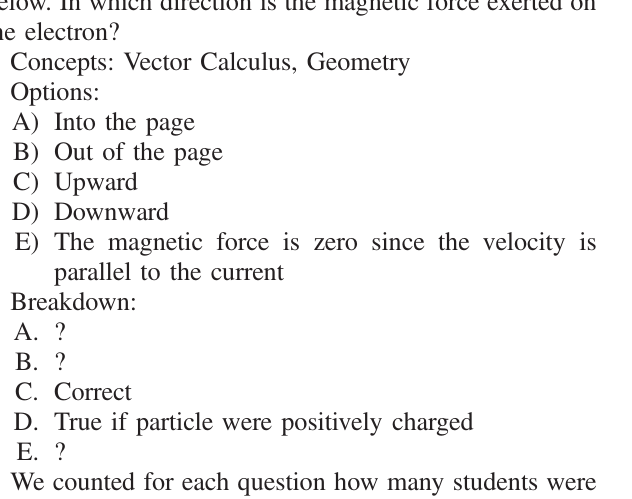
VIII. MC Results: Bold indicates the correct response. If the Group = VC ¼ 0 , students have not taken vector calculus prior to physics 2, whereas if Group = VC ¼ 1 students have taken vector calculus prior to physics